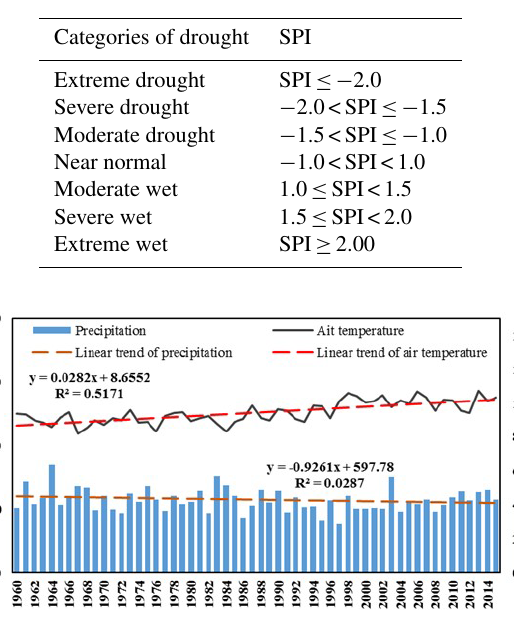
Figure 2. Temporal variations of annual average air temperature and total precipitation in the Wei River